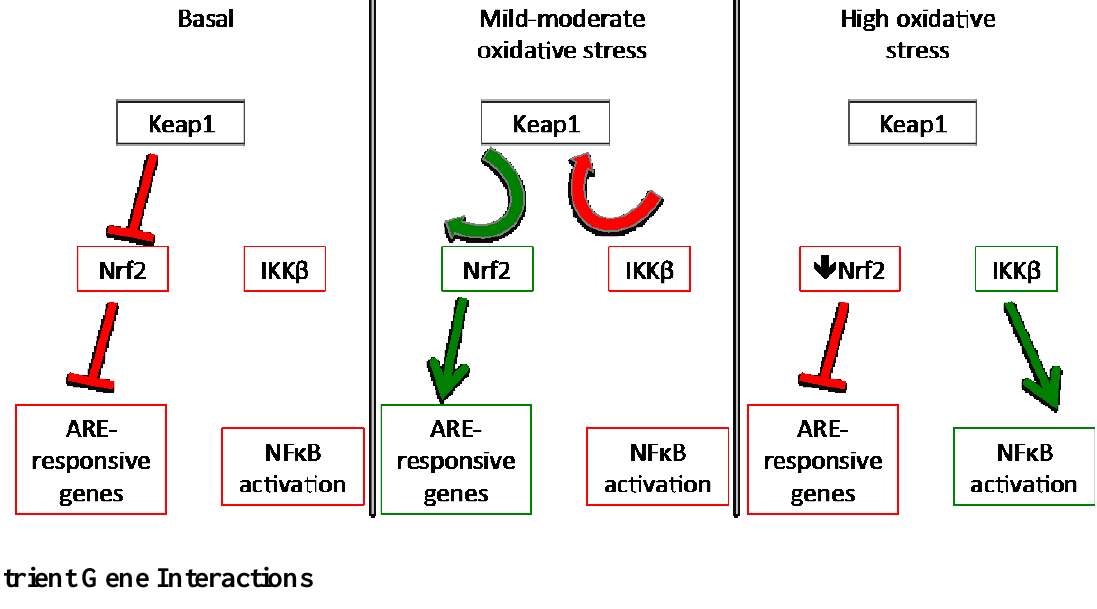
Figure 3. Keap1 as the coordinating factor between Nrf2 activation and NFκB